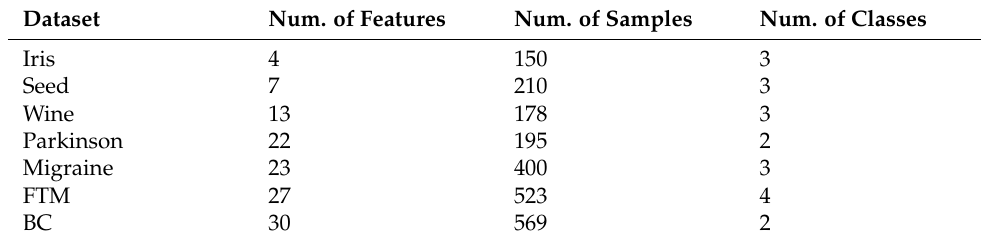
Table 1. Information on the seven